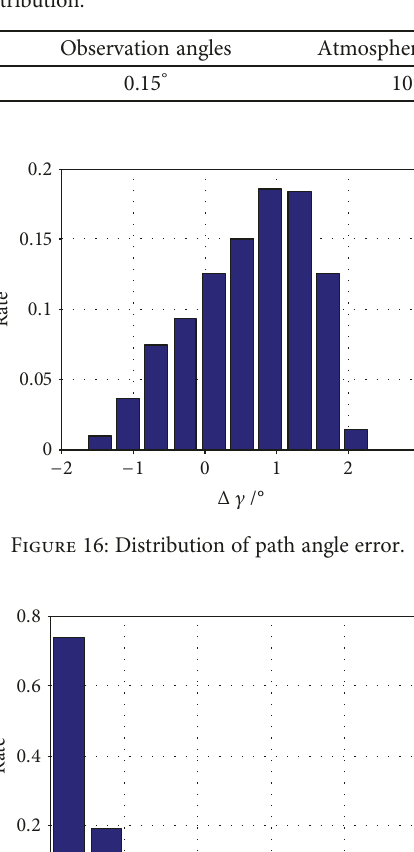
Table 4: Type and size of error distribution.